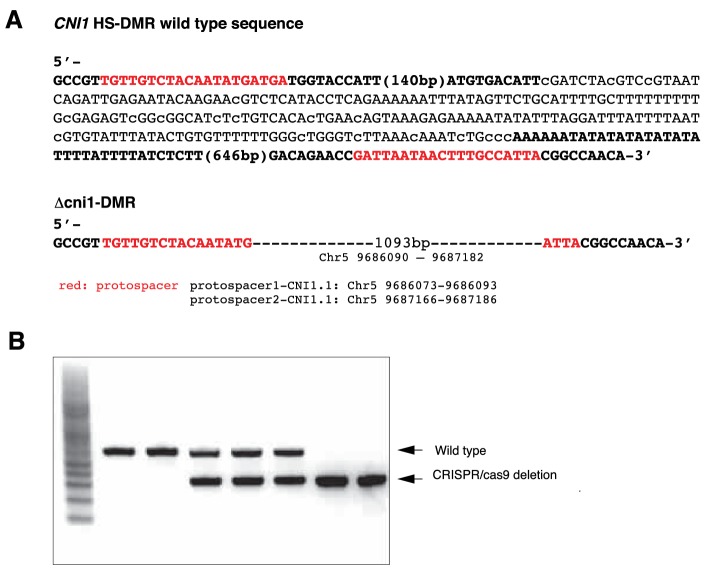
Generation of CRISPR/Cas9 deletions at the CNI1 HS-DMR region.(A) Sequence of the flanking CNI1 HS-DMR selected for targeted genome editing (methylated cytosines in lower case) and sequence of the CNI1 HS-DMR deletion line generated by CRISPR/Cas9 genome editing. (B) PCR amplicons from genomic DNA of plants segregating for wild type sequence and Δcni1 HS-DMR.